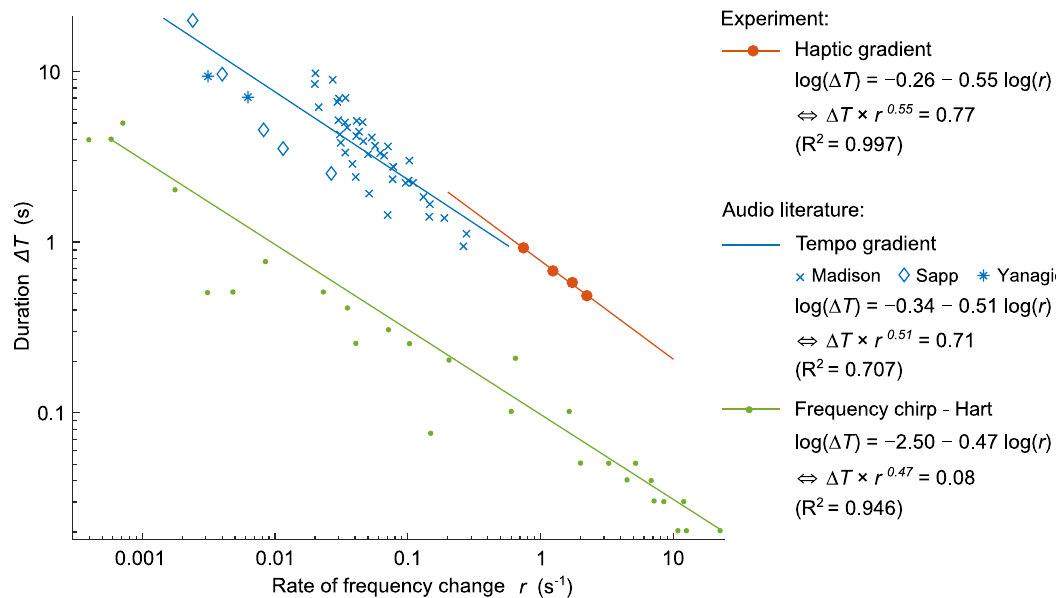
Figure 2. Comparison of the experimental results with the literature. Data points are fitted with logarithmic regressions (displayed as solid lines). The regression equations are presented in two forms with their goodness of fit. Thresholds for the haptic gradients, converted to time with the finger velocity value, are shown in red. Thresholds from the literature on the perception of tempo gradients (accelerando) 23–25 are displayed in blue. Thresholds from the meta-analysis of Hart 26 , who gathered data from many studies on the perception of frequency chirps (glissando), are shown in green 27–31